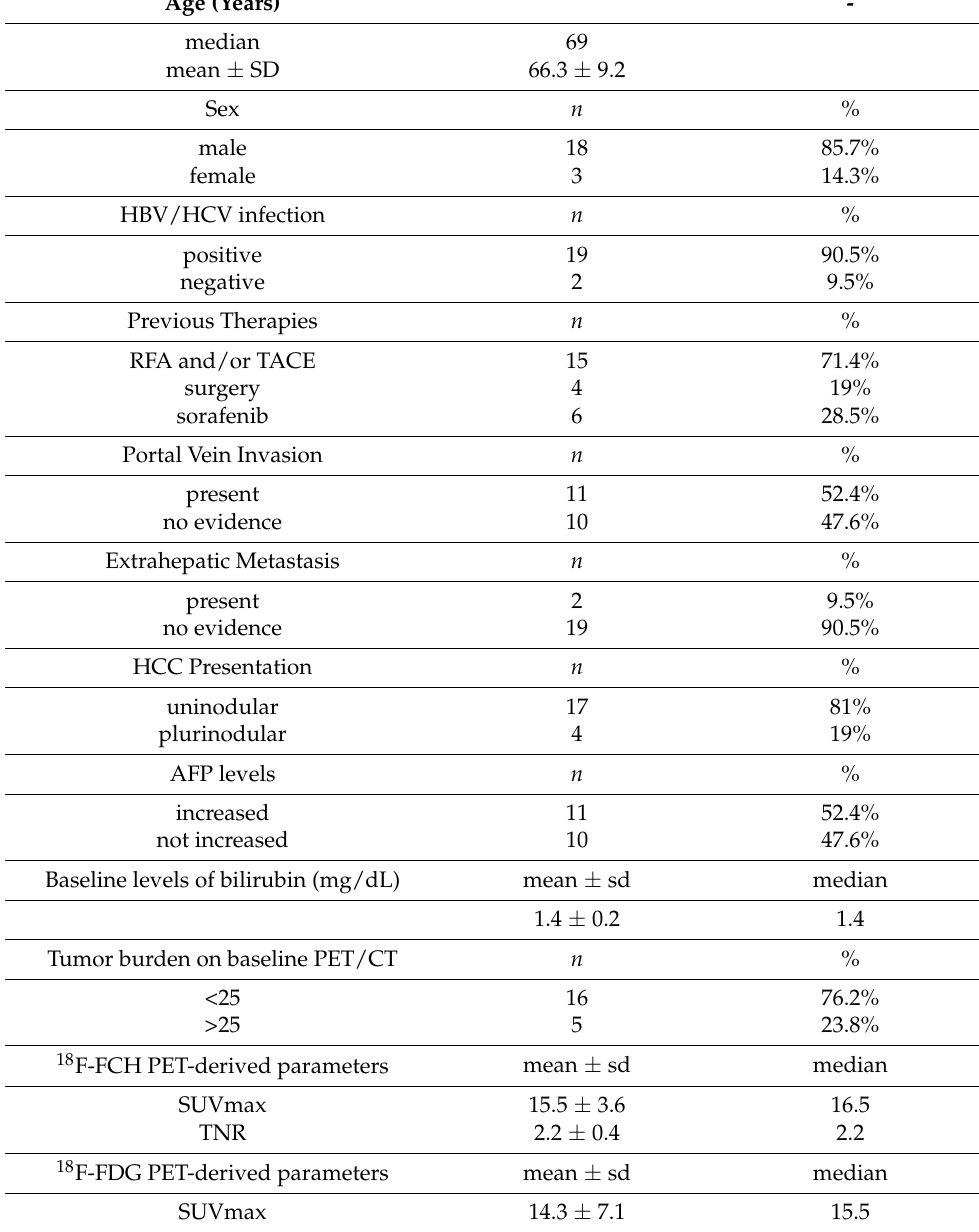
Table 1. Patients’ baseline clinical–demographic features and results of quantitative